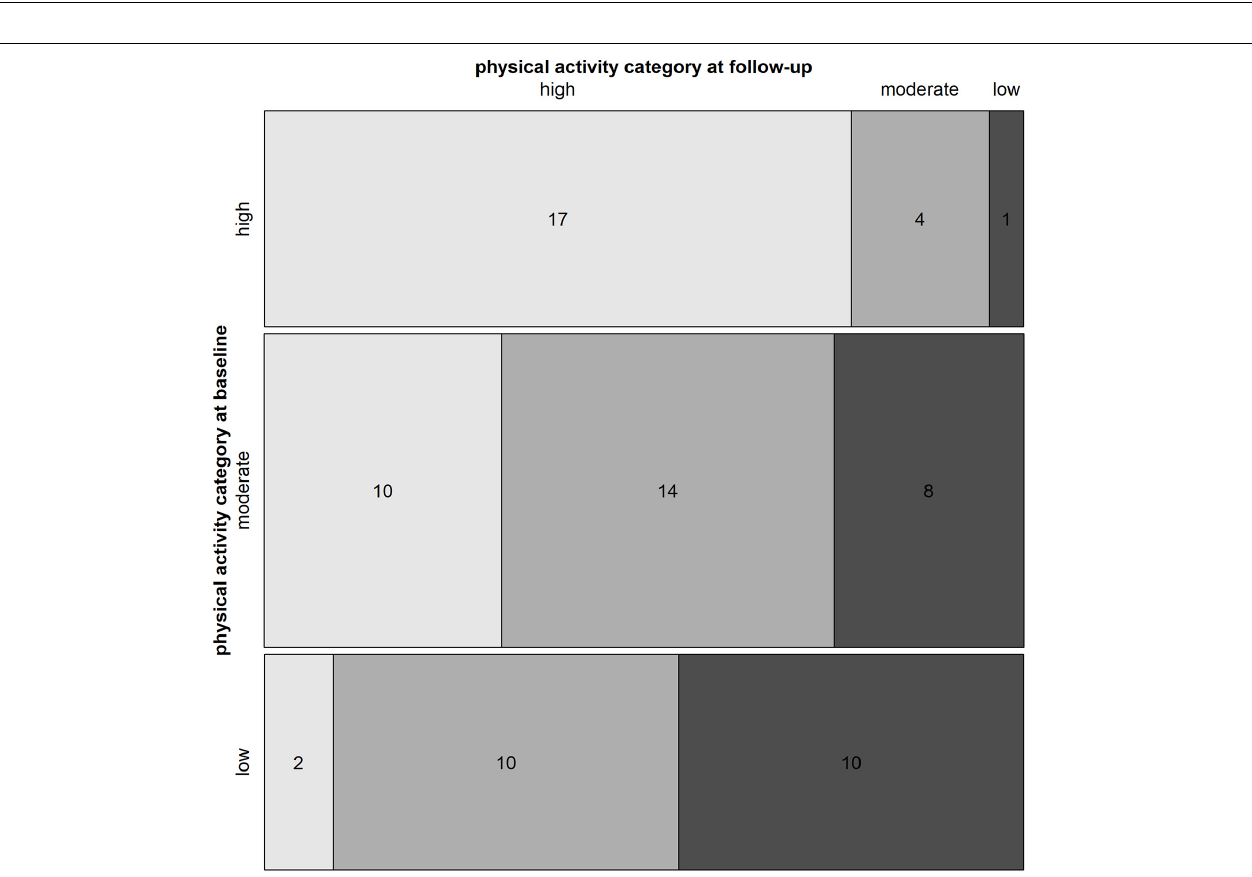
FIGURE 3 | Physical activity categories at baseline (before the COVID-19 pandemic) and follow-up (during the lockdown). The mosaic plot shows three horizontal bars, with one bar per category of physical activity (“low,” “moderate,” and “high”). The colored areas of the horizontal bars represent the proportion of the study participants which reached the physical activity categories “high” (light gray), “moderate” (gray), and “low” (dark gray) at follow-up. The numbers represent the number of participants.